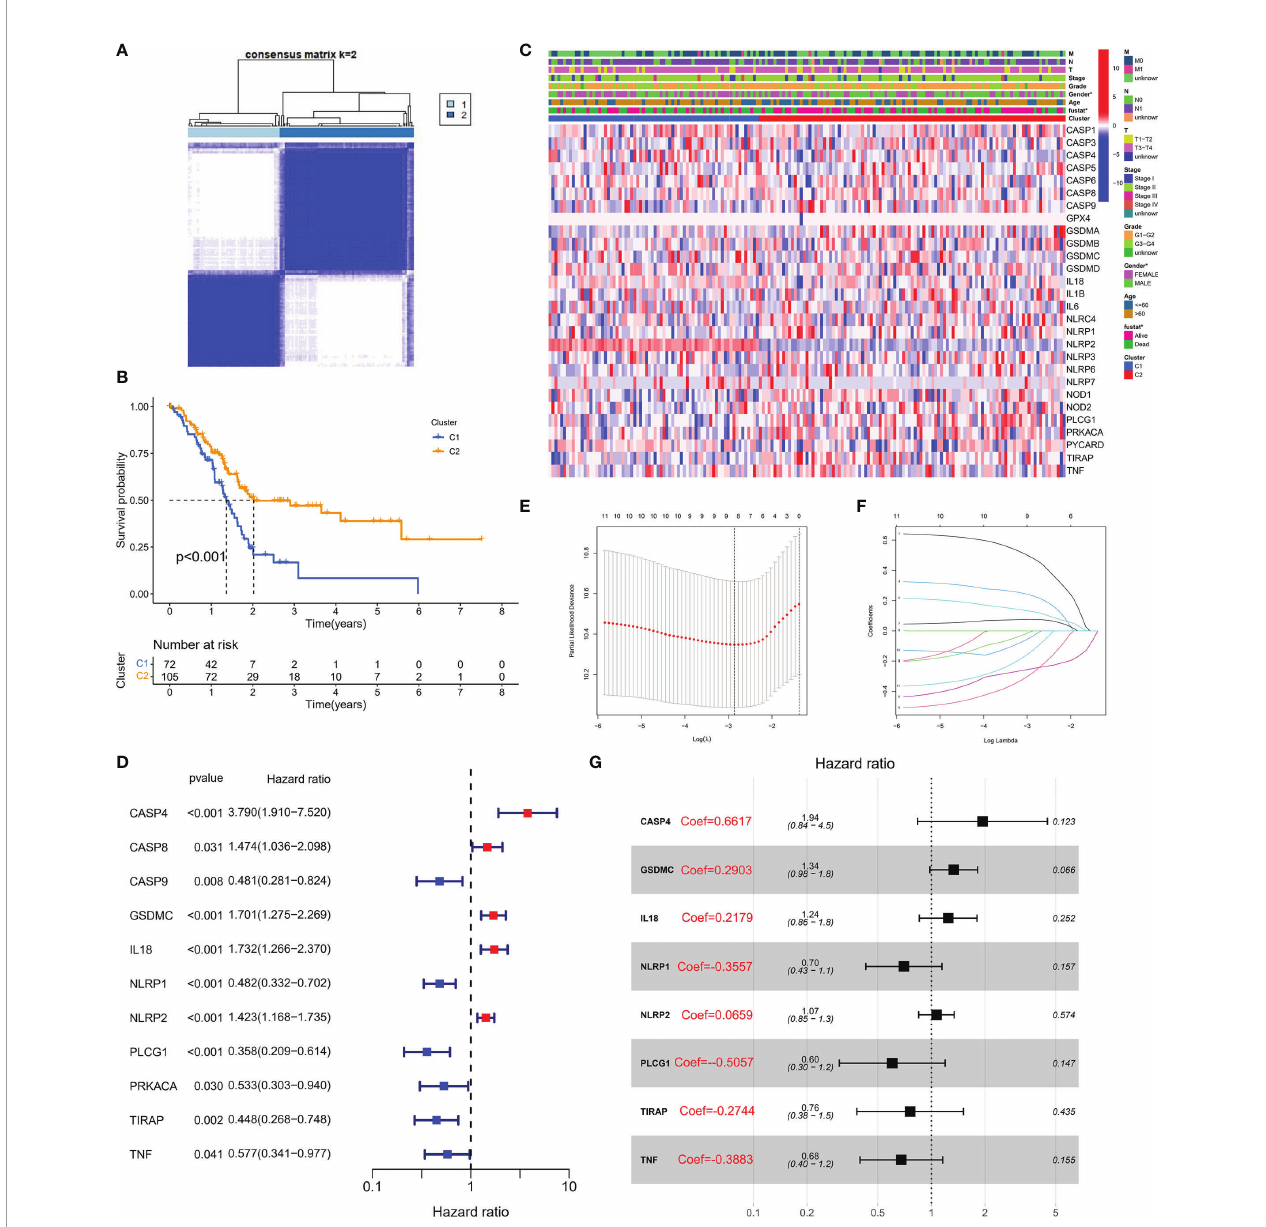
FIGURE 2 | Molecular subtypes and risk status based on PRG expression. (A) According to the consensus clustering matrix (k = 2), 190 PC subjects were strati fi ed into two groups. (B) Kaplan – Meier curves for the two clusters. (C) The heatmap along with the clinicopathologic characteristics of the two clusters established using these DEGs and clinical variables. (T refers to tumor, N refers to lymph node, and M refers to distant metastasis). T1 means that the tumor is less than 2 cm, T2 is the tumor in 2 – 4 cm, T3 is the tumor larger than 4 cm, and T4 is the tumor regardless of size but invades the celiac artery, superior mesenteric artery, or common hepatic artery. N refers to lymph nodes, N1 refers to regional metastases in one to three lymph nodes, N2 refers to regional metastases in four or more lymph nodes, and M1 refers to distant metastasis of the tumor. On this basis, the combination of the three TNM indicators was used to draw a speci fi c stage (stage). G1, G2, and G3 are the degree of tumor differentiation (G1: highly differentiated; G2: moderately differentiated; G3: poorly differentiated). (D) Univariate Cox regression analysis of PRGs in TCGA cohort. (E) Cross-veri fi cation was adopted to fi ne-tune the selection of parameters in LASSO regression. (F) LASSO regression of 11 genes linked to PC. (G) Multivariate Cox regression analysis of PRGs in TCGA